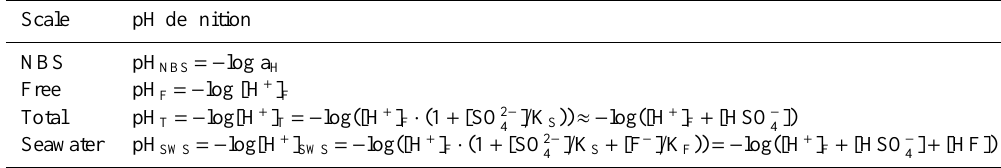
Table 1. pH scales used on seawater measurements, definitions, and relationships (Dickson, 1993; Dickson et al., 2007; Millero, 2007).